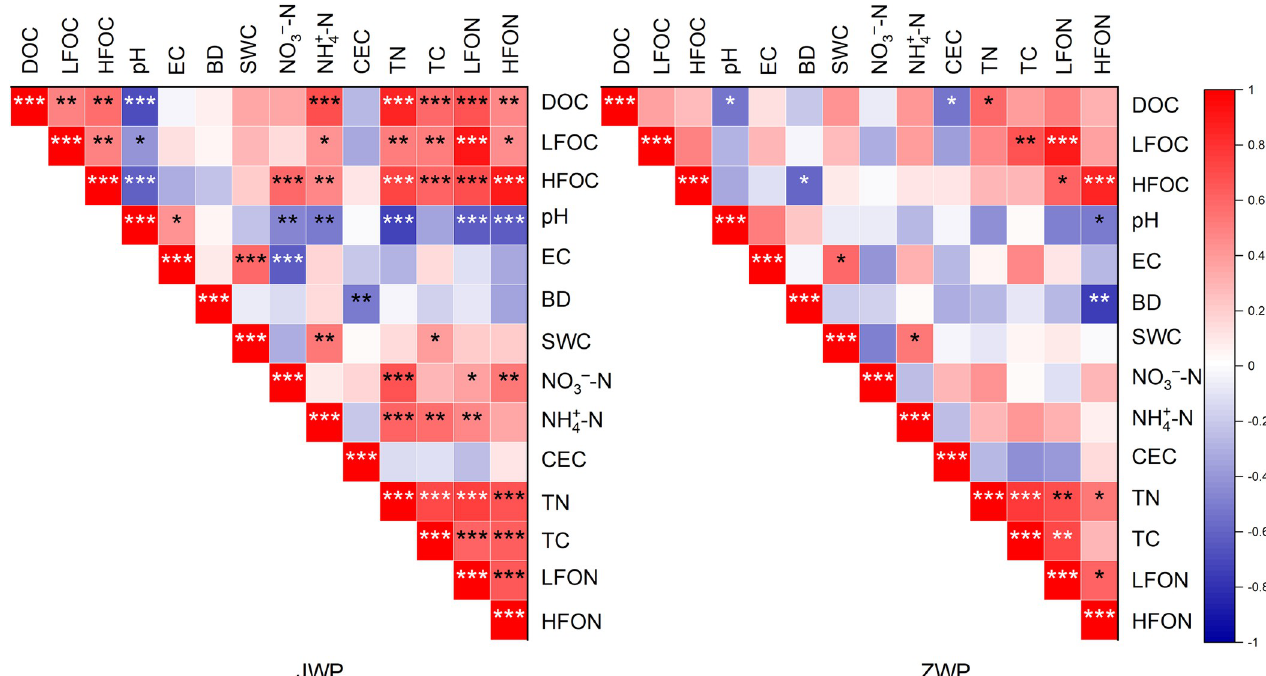
Fig 6. Spearman’s correlation analysis between SOC and various environmental factors in two wetland parks. JWP: Shili Lake Ecological Wetland Park; ZWP: Shandong Zoucheng Taiping National Wetland Park. Blue means negative correlation. Red mean positive correlation. The darker the color, the greater the correlation. EC: electrical conductivity; BD: soil bulk density; SWC: soil water content; LFON: light fraction organic nitrogen; HFON: heavy fraction organic nitrogen. Other abbreviations as in Figs 4 and 5. � : p < 0.05; �� : p < 0.01; ��� : p < 0.001. https://doi.org/10.1371/journal.pone.0282014.g006 in ZWP were longer than those in JWP. Our analysis showed that even though the restoration times were different, the soil pH of the farmland was significantly lower than that of the wet- land and lakeside grassland due to the long-term nitrogen fertilization. The relationship between carbon and nitrogen in the two wetland parks was strongly coupled, indicating that carbon and nitrogen had a strong correlation, consistent with previous study [47]. For exam- ple, the LFOC contents were found to be closely related to LFON and NO 3– -N in both wetland parks. NO 3– -N is one of the inorganic nitrogen sources needed for plant growth and is among the effective nitrogen sources that plants can directly use. LFOC and LFON were mainly derived from plant granular organic residues, meanwhile their turnover was faster which – -N [48]. A study has shown that the main helped to provide phytonutrients, including NO 3 determinants of soil carbon persistence differed between soil layers, and that plant carbon input was the main control of long-term soil carbon persistence in topsoil, which was the chief Table 2. Stepwise multiple linear regression for SOC in JWP.